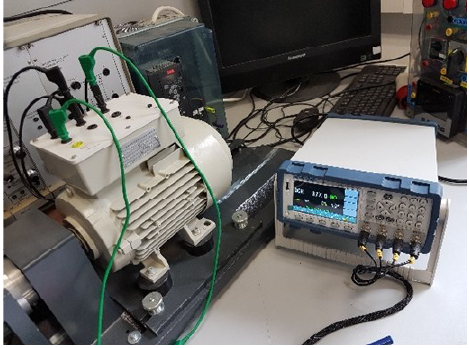
Figure 8. Workbench for the stator winding resistance measurements vs. frequency change.